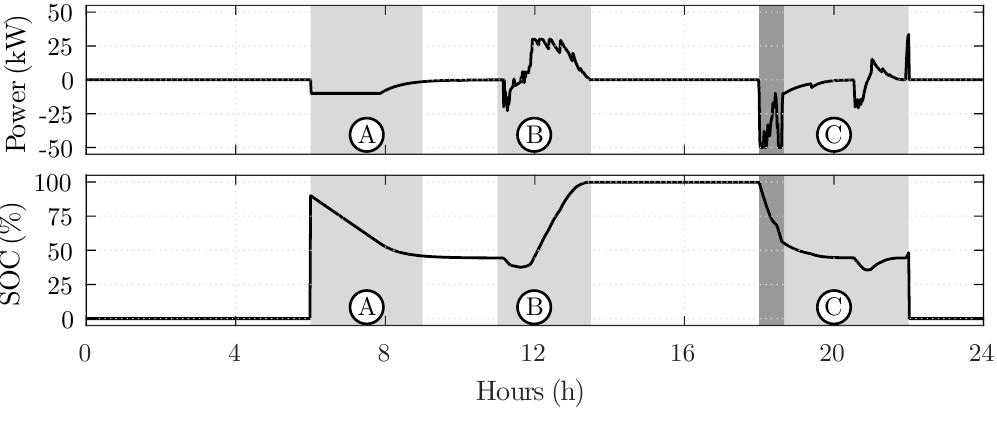
Figure 10. Charging power profile and SOC of a vehicle in V2G